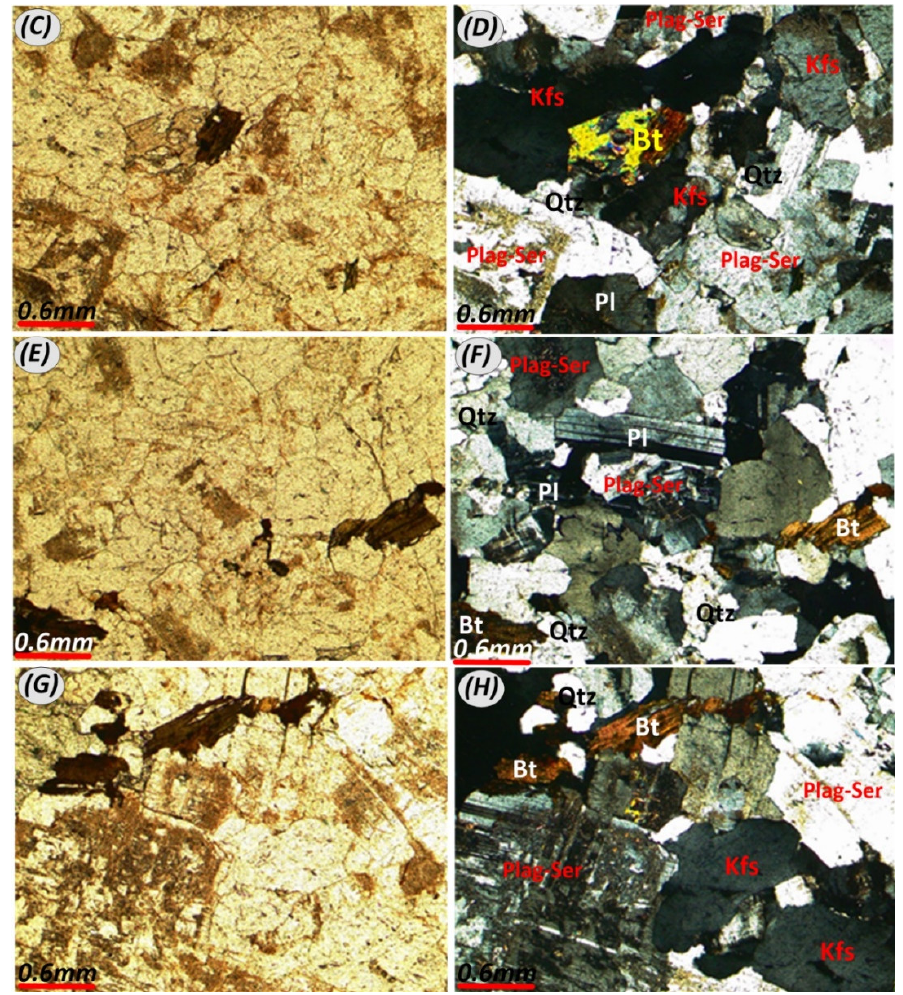
Figure 5. Mongo massif; ( A ) outcropping conditions (field of view is 20 m wide); ( B ) hand sample; ( C – H ) thin slide optical microscope views alternatively without or with crossed nicols ( left and right ) with phase identification indicated (quartz = Qtz, orthose = Or or Kfs, biotite = Bt, sericitized plagioclase = Plag-Ser). Table 1. Mineralogical mode in percent of the Oyo and Mongo Massif samples.